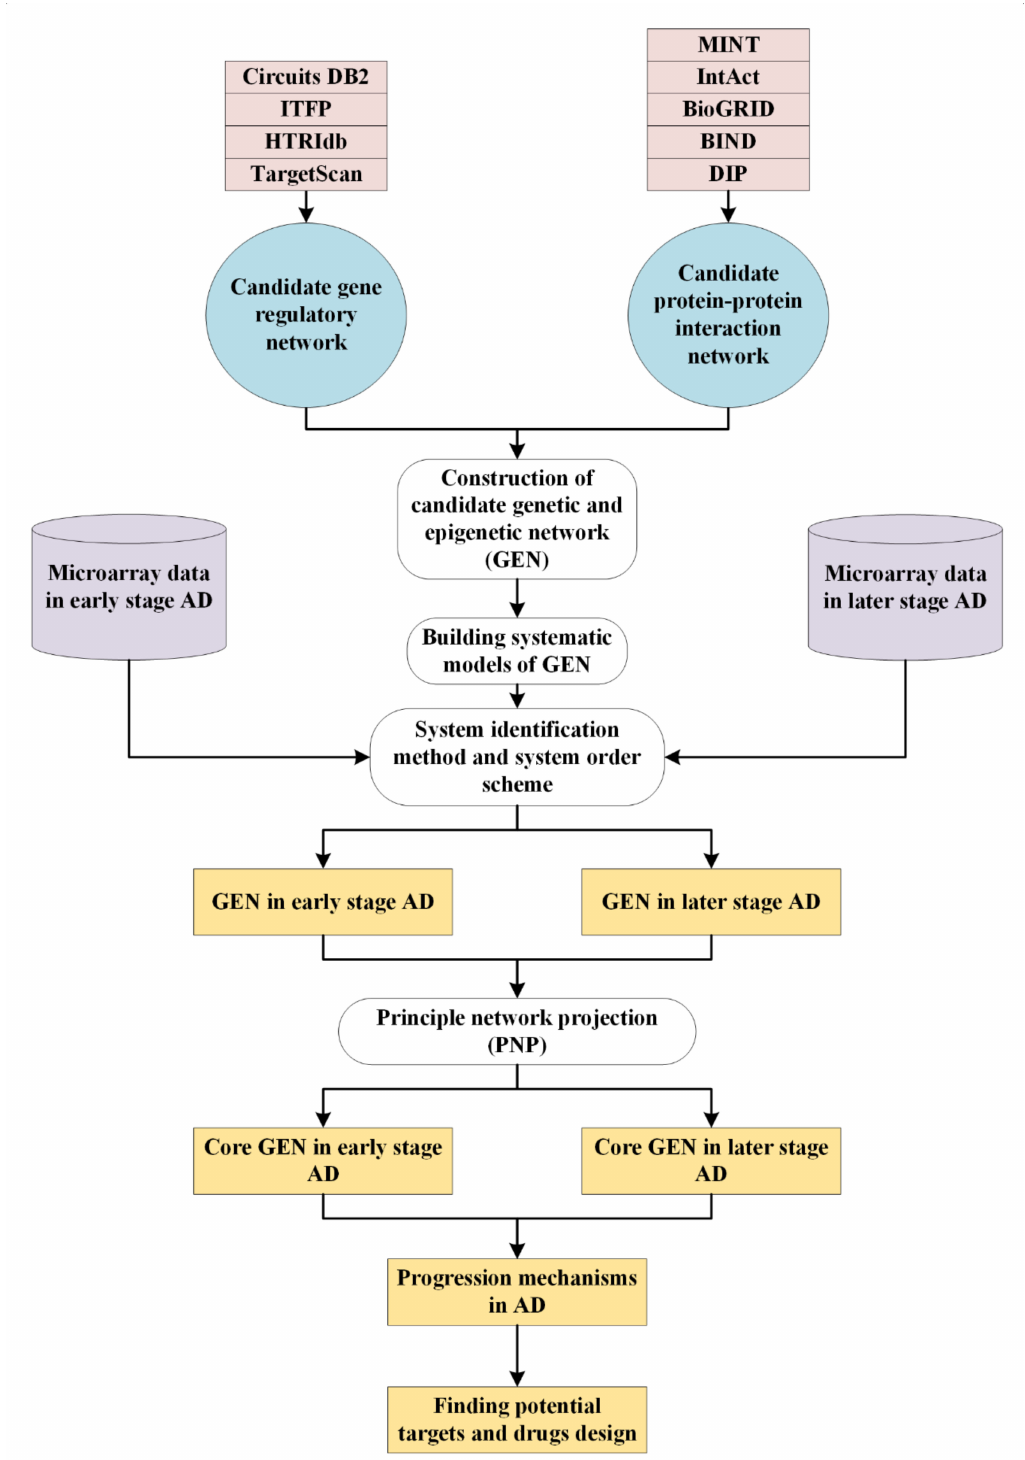
Figure 1. The research flowchart to investigate pathogenetic mechanisms of Alzheimer’s disease by systems biology approaches for drug discovery. The candidate genome-wide genetic and epigenetic network (GEN), which is composed of protein-protein interaction network (PPIN) and gene regulatory network (GRN), is built by mining big databases. The microarray data in early and later stage AD are shown in purple blocks. The rounded rectangular blocks indicate the schemes and methods utilized to construct the real and core GENs for early and later stage AD, respectively. The yellow blocks show the identified real GENs, core GENs, progression mechanisms, and the potential drug targets for the early and later stage